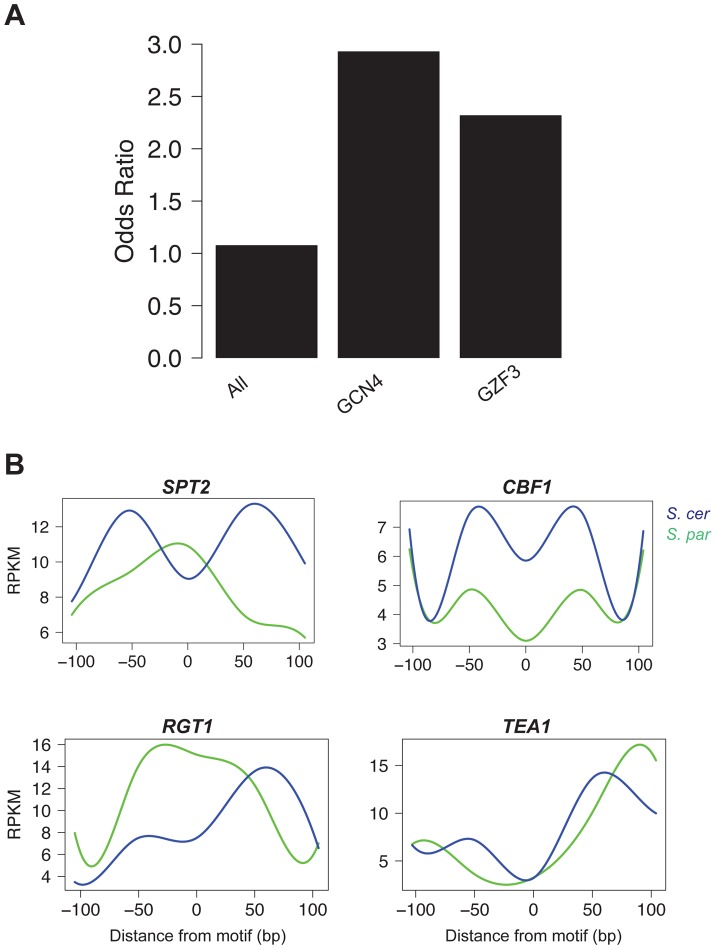
Motifs contributing to cis and trans effects.A. The odds ratio of observing a disrupted motif compared to a non-disrupted motif in NFRs with a significant cis effect. Odds ratios are shown for all motifs, as well as the two individual motifs (GCN4 and GZF3) that were found to be significant by permutations (FDR = 0.10). B. Pattern of accessibility for four motifs found within trans effect NFRs that vary between S. cerevisiae and S. paradoxus.